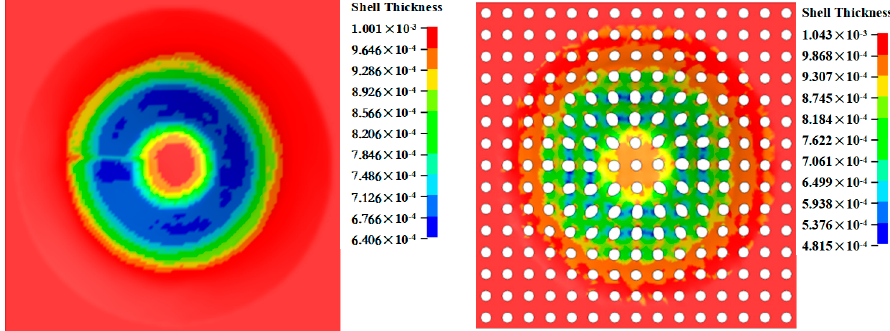
Figure 10. Cloud map of wall thickness distribution of titanium plate and perforated titanium sheet.